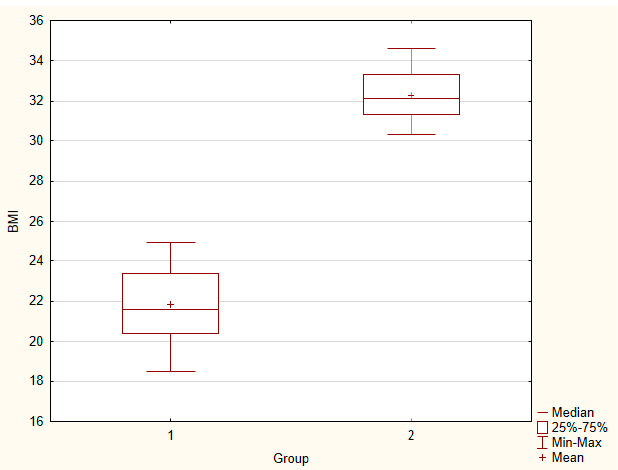
Figure 1. Body mass index of control group (1) and study group (2). U = 0.00, p = 0.000.